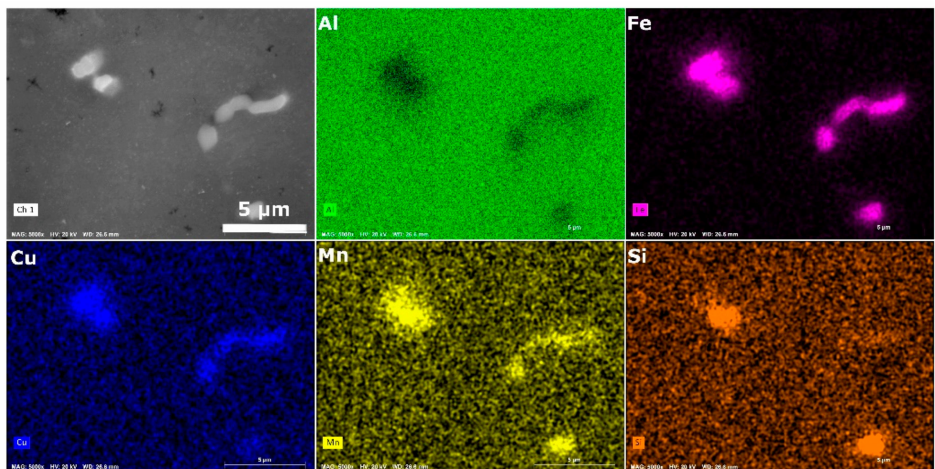
Figure 5. SEM/EDS analysis of the intermetallic particles.